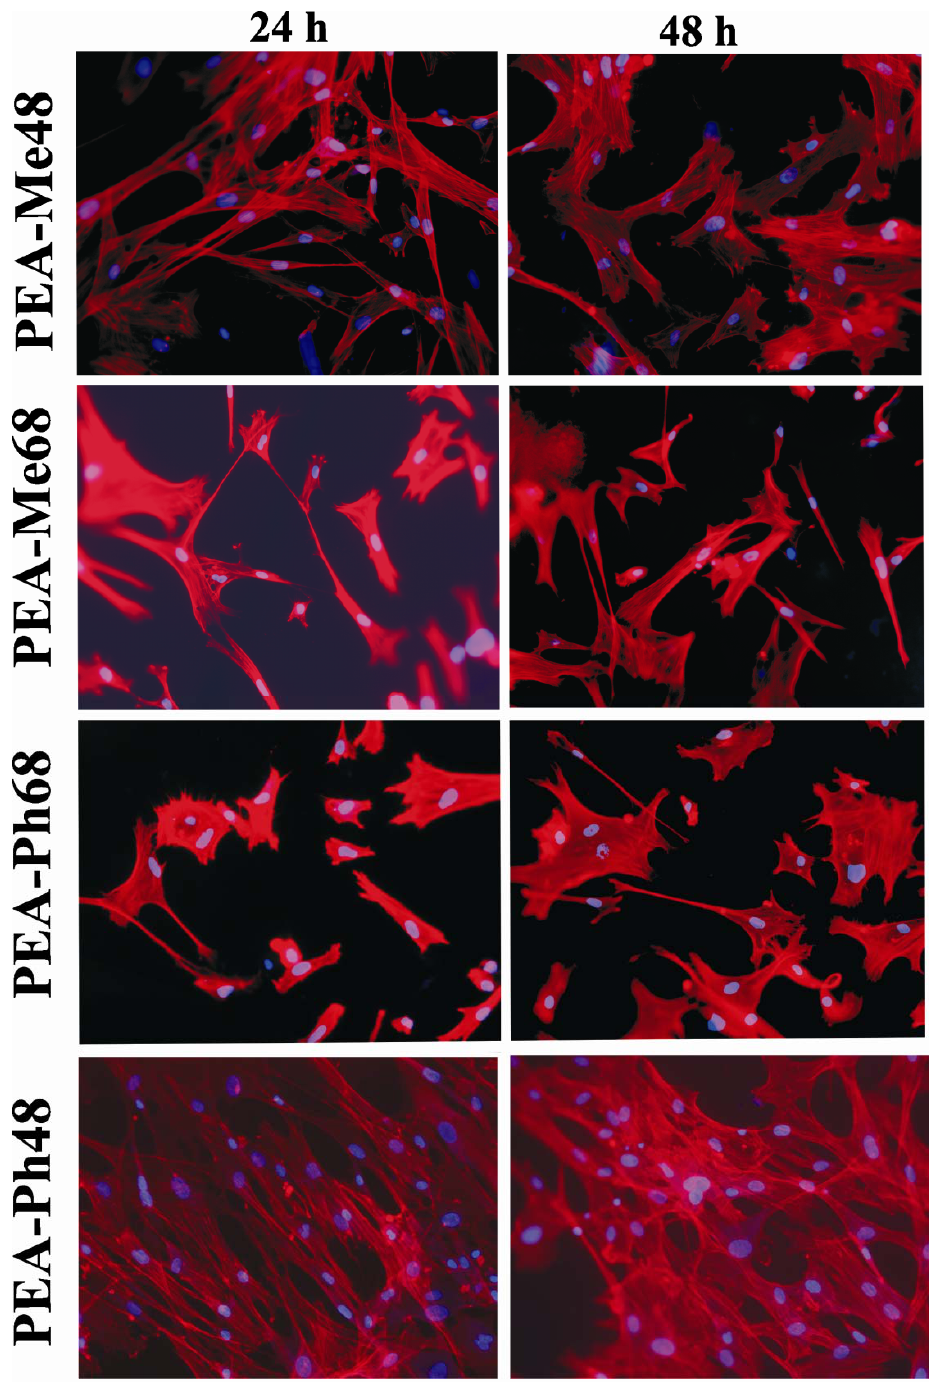
Figure 10. Human coronary artery smooth muscle cells attachment and spreading on films of PEAs synthesized from the amino acids L -phenylalanine and L -methionine. A well- spread morphology is evident for all the polymers and up to 48 h culture